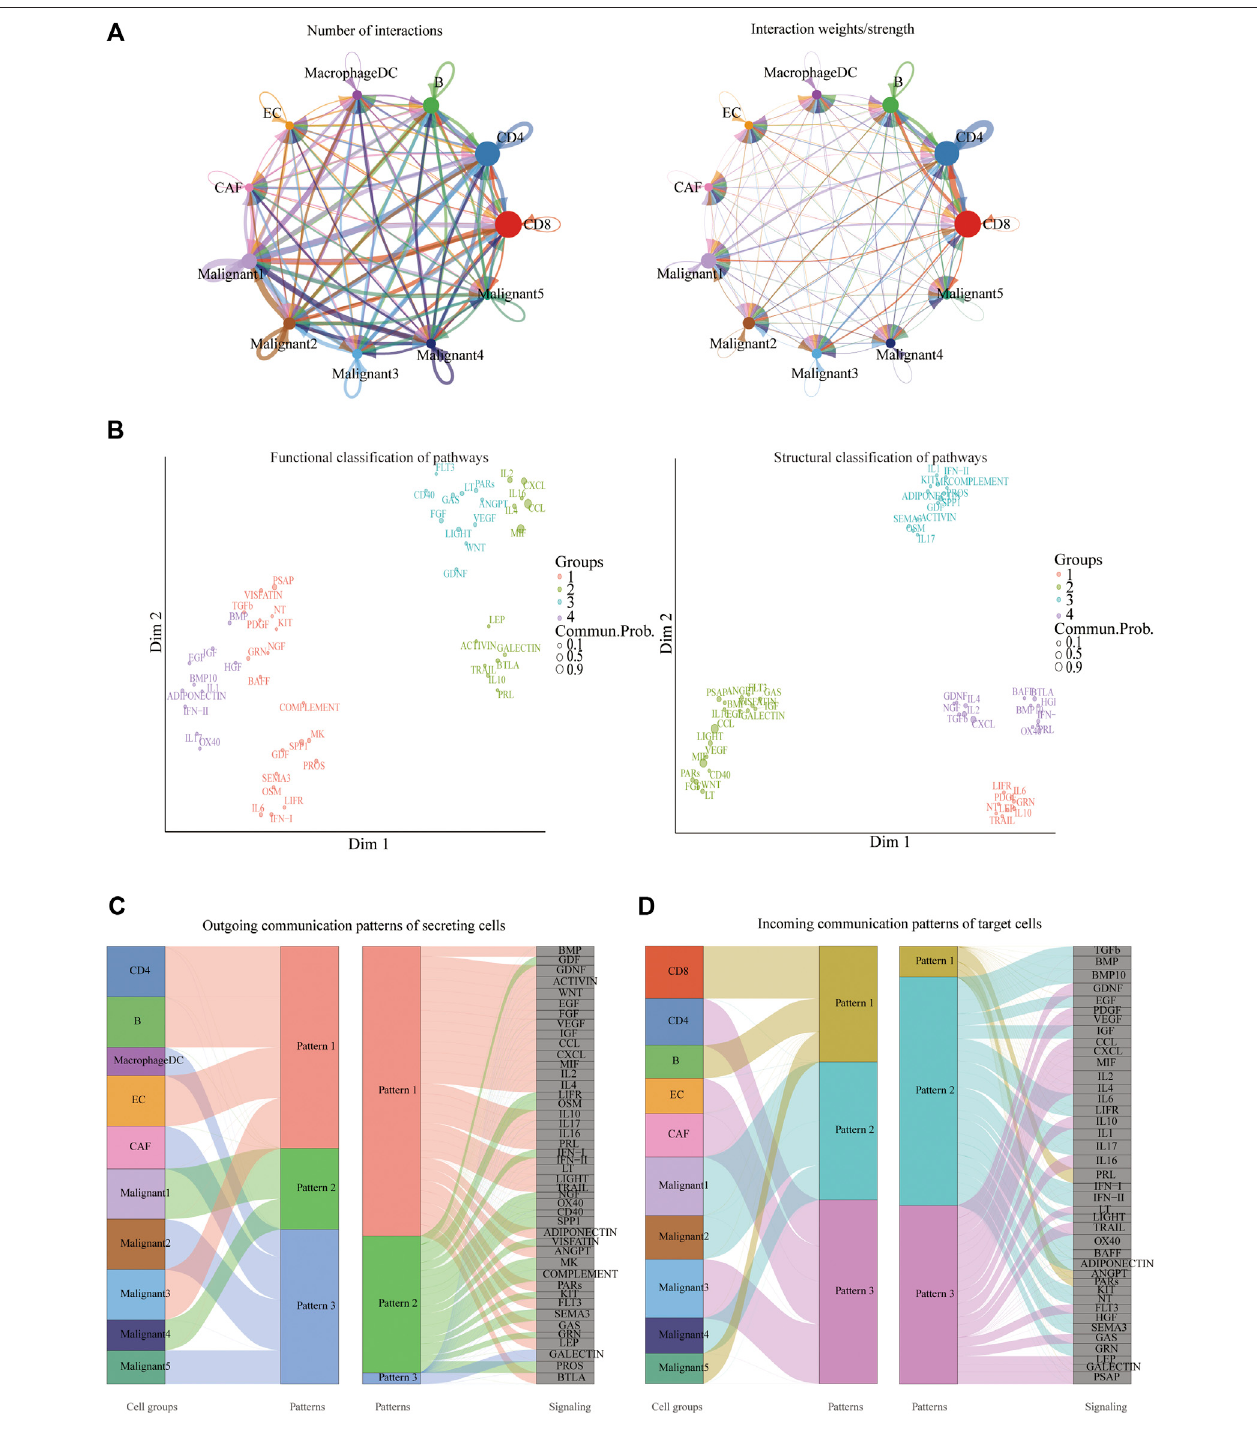
FIGURE4| Crosstalkbetweencancerandimmunecells. (A) Anoverviewofcell-cellinteractions.Arrowandedgecolorindicatedirection.Edgethicknessindicates thenumber(Left) ortheweighted(Right) ofinteraction betweenpopulations.Theloopsindicateautocrinecircuits. (B) Classi fi cationofsignaling pathways based ontheir functional similarity (Left) and structural similarity (Right). Each dot represents a signaling pathway. (C) Outgoing signaling patterns of secreting cells. (D) Incoming signaling patterns of target cells.